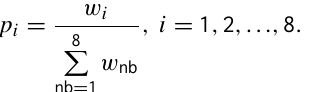
Figure 3. Definition of cellular direction d i and cellular dis- tance (cid:49) i . For example, d 1 = (1, 0), d 6 = ( − 1 √ =√ (cid:49) 6